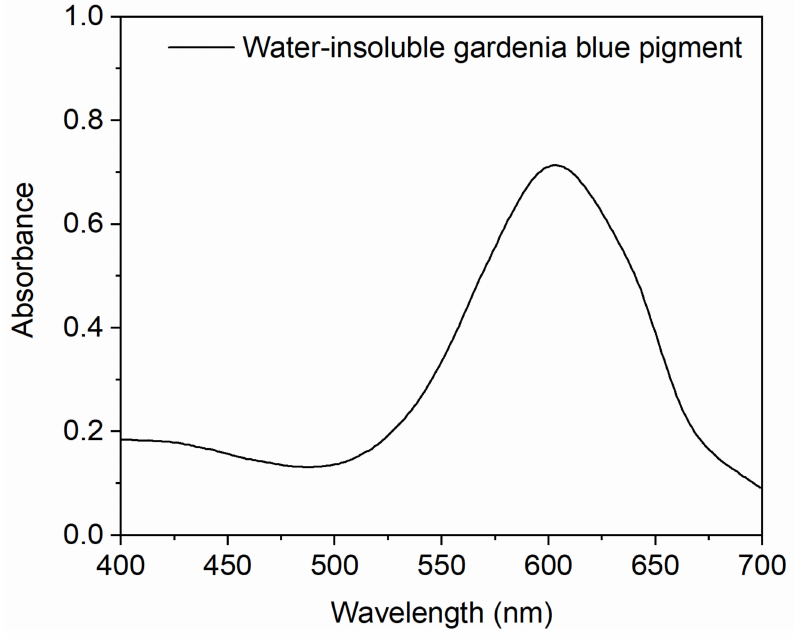
Figure 3. The UV-vis of water-insoluble gardenia blue pigment. 3.5. The Characteristic Function Group Analysis of Water-Insoluble Gardenia Blue Pigment Study on the characteristic functional groups of water-insoluble gardenia blue pig- ments by FTIR and XPS. The FTIR characteristic peaks were showed in Figure 4: